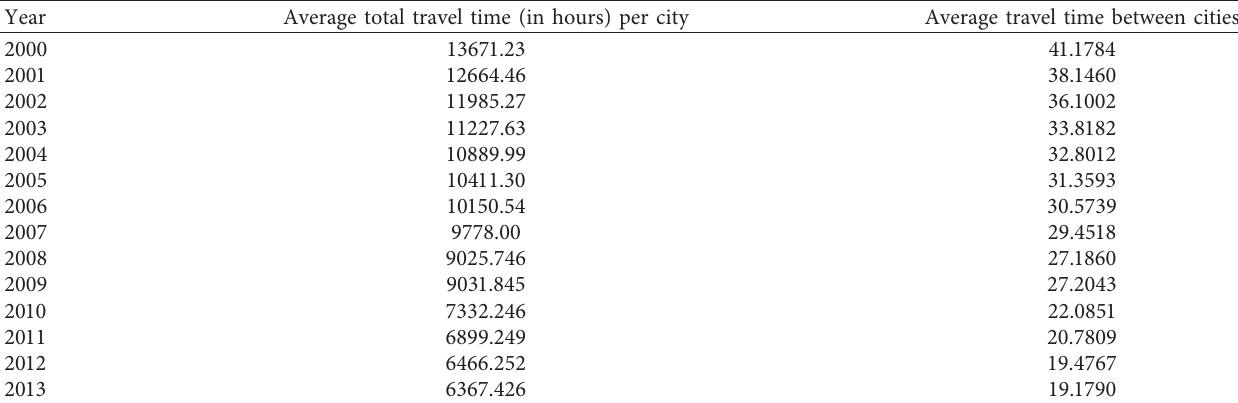
Table 1: The shortest travel time for highways in